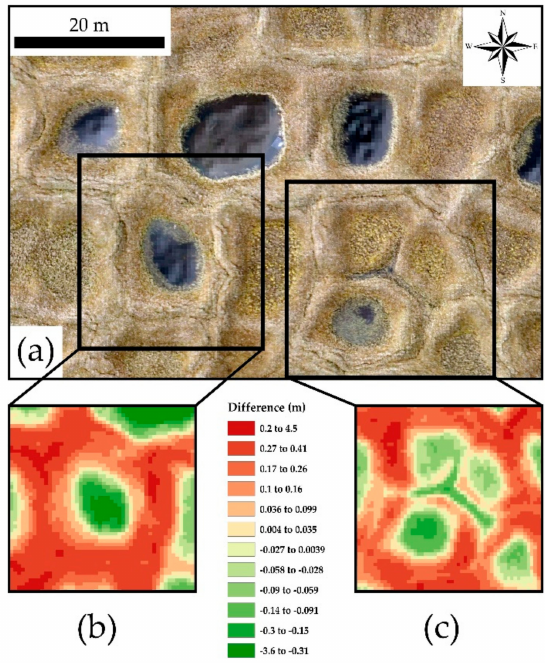
Figure 4. An example of low-centered polygons (LCP) in ( a ) an orthophoto map that is mixed with a GSR map and ( b,c ) a map of local di ff erentiation of the relief that shows a di ff erence between mean DTM, which was derived from DTM averaging with a moving window of 50 m, and actual DTM. Red color marks elevated terrains and green color marks local hollows. These maps show that the elevation of troughs was greater than polygon centers in LCP (2.1) (b), LCP with water-filled centers (2.2) (b), and even in LCP with water-filled troughs (2.3)